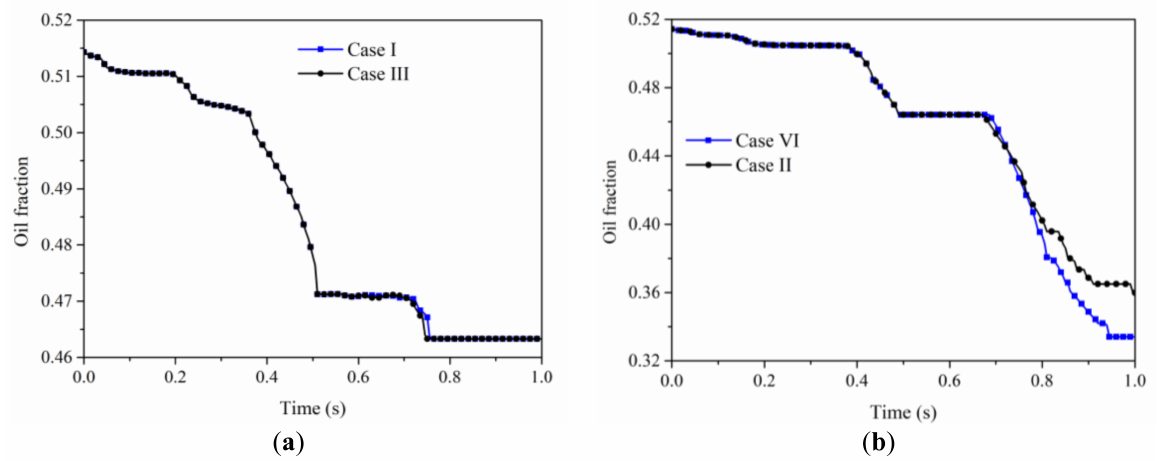
Figure 19. Comparison of oil saturation variation with time between continuous injection and alternate injection: ( a ) small particles, ( b ) large